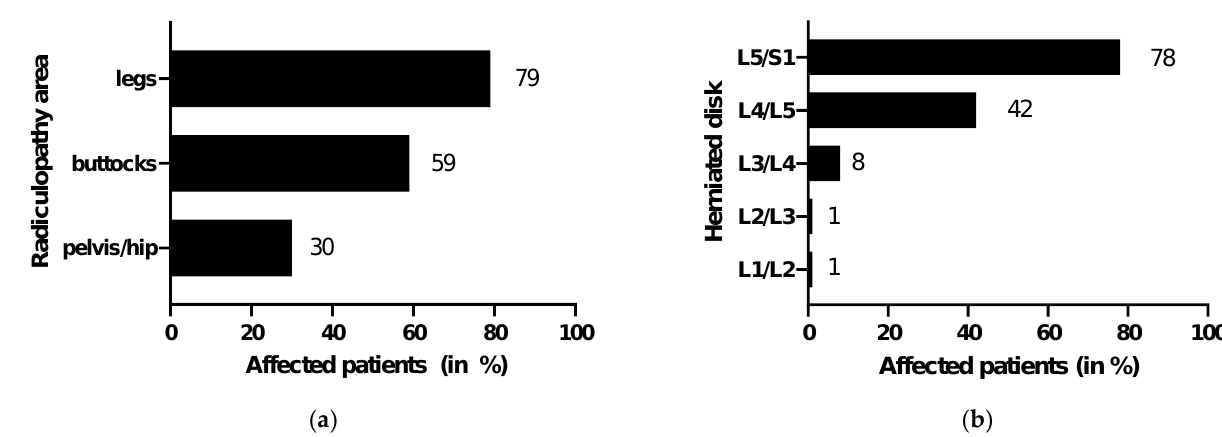
Figure 1. Characteristics of symptoms related to the area of radiculopathy ( a ) and the affected disk level ( b ).